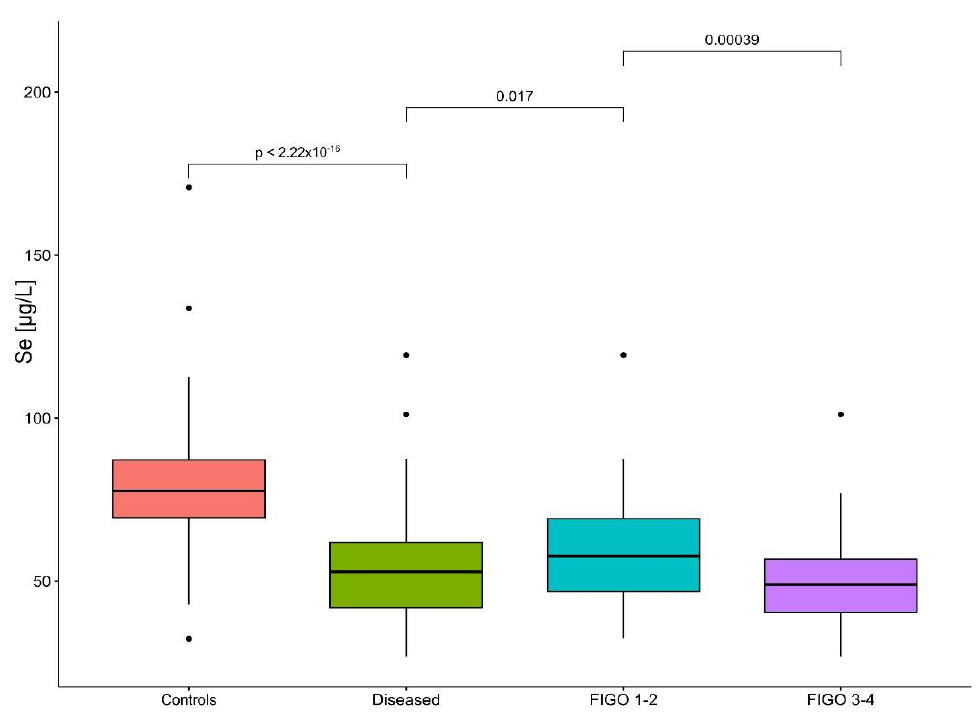
Figure 1. Distribution of selenium level for study subjects. Dots visible on the figure present outliers. The mean and median concentration for the control group were 78.99 and 77.72 μg/L, respectively, and for the women diagnosed with ovarian cancer, 53.31 and 52.89 μg/L, respectively. Among the cases, the mean selenium level decreased with the advancement of the neoplastic process. The mean concentration and median for the stages of FIGO I – II were 59.20 and 57.86 μg/L, and for the FIGO III and IV subgroup , 49.86 and 48.86 μg /L, respectively. In the study subgroups, univariable and multivariable analyzes show an in- creased incidence of ovarian cancer in patients with a lower selenium concentration. The